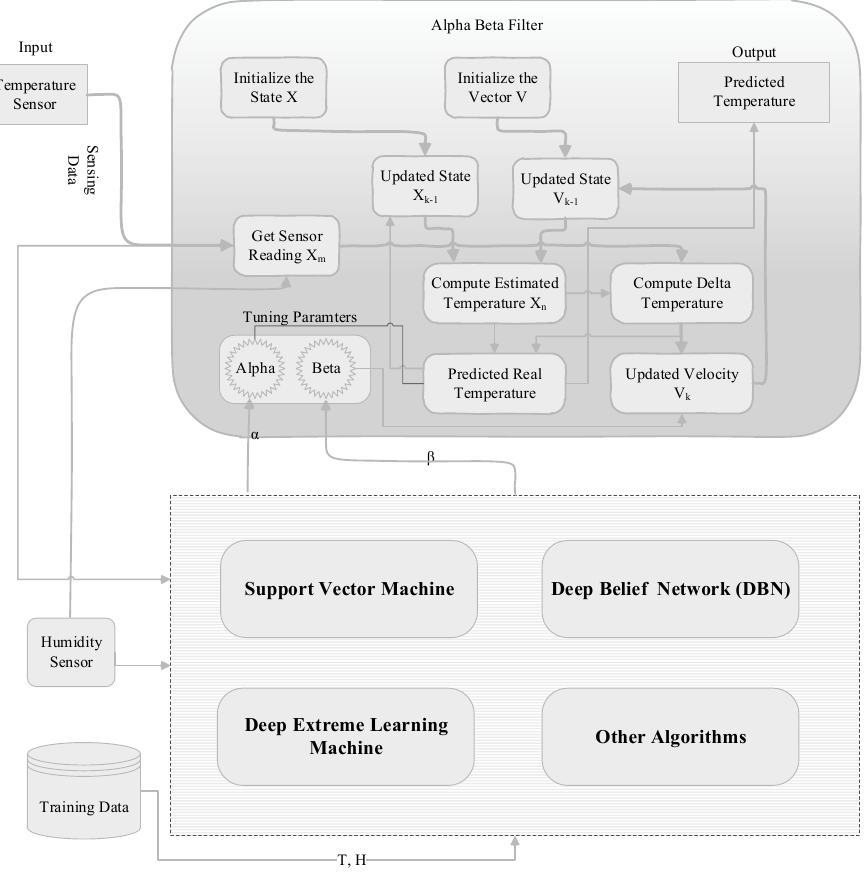
Figure 2. The complete architecture of our proposed scheme.